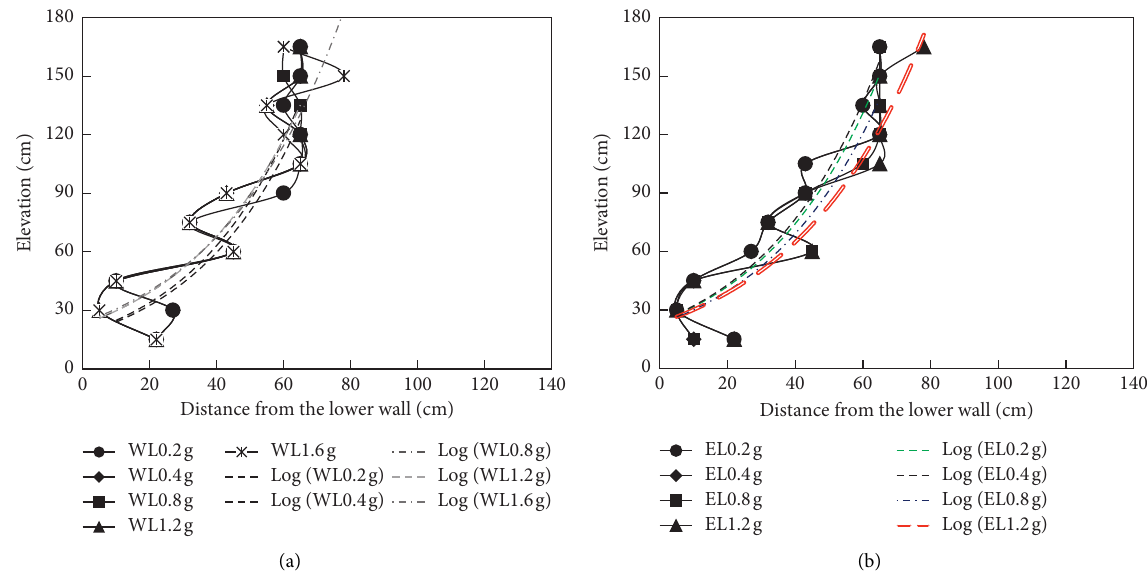
Figure 19: Fitting curve of specimen 1 potential failure surface. (a) WL fitting curve. (b) EL fitting curve.